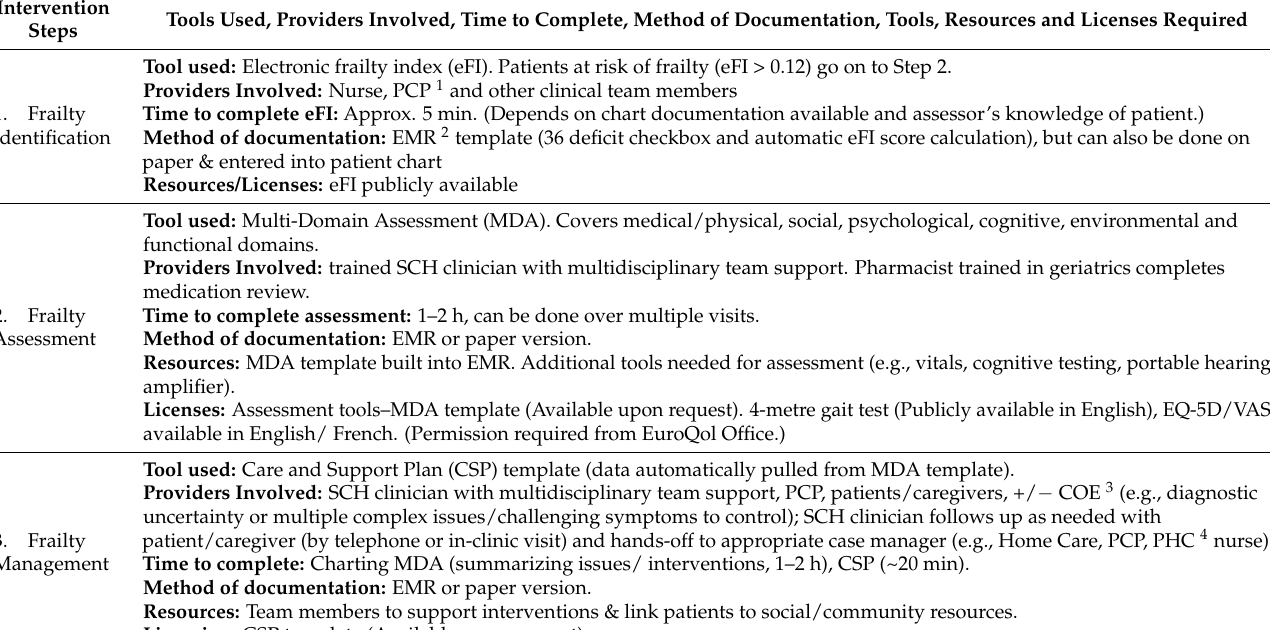
Table 1. SCH process of